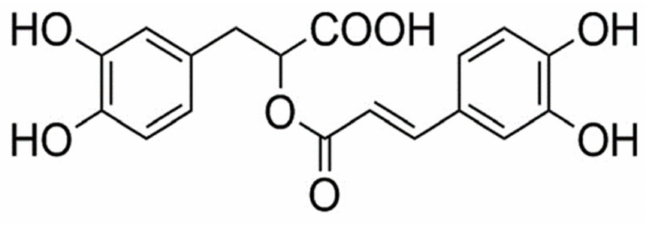
Figure 1. Chemical structure of rosmarinic acid